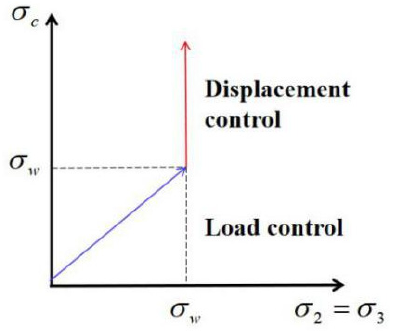
Figure 6. Loading system.